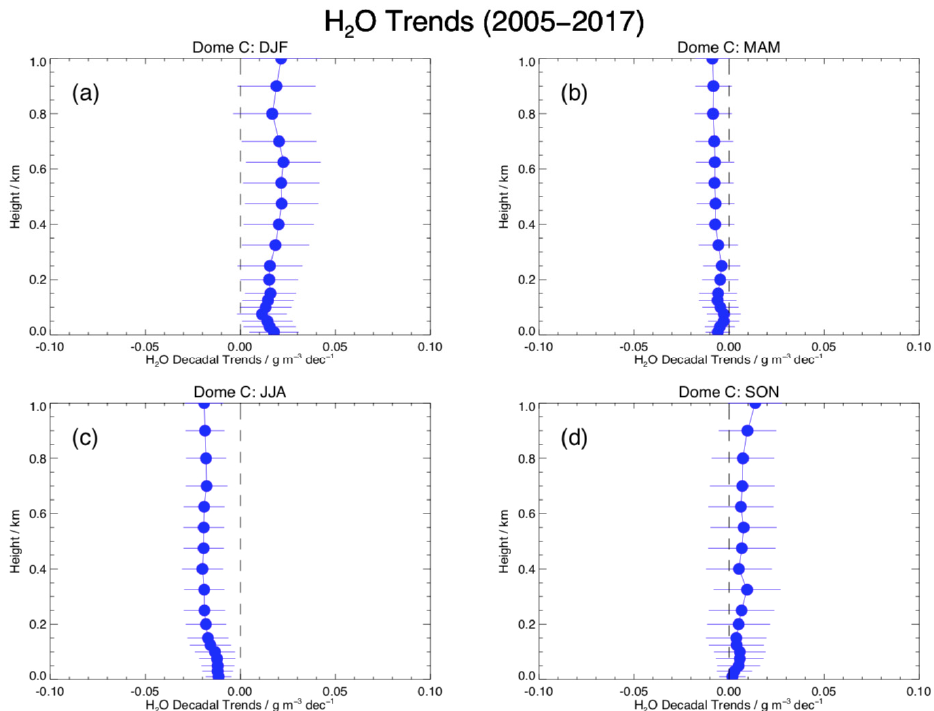
Figure 7. Mean profile of the decadal linear trends in water vapor (H 2 O) at Dome C from radiosondes over the period 2005–2017 in: ( a ) DJF; ( b ) MAM; ( c ) JJA; and ( d ) SON. Horizontal bars represent 1- σ error.